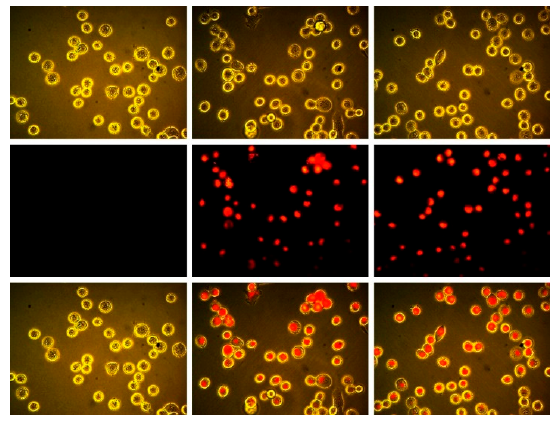
Figure 4. Brightfield ( upper ), epifluorescence (( middle ) λ ex = BP 528–553 nm, λ em = BP 578–633 nm), and ( lower ) overlay images of MDA-MB 231 breast tumor cells. DMSO control ( left ), treated with 50 µM F 3 SPc(C 3 ) ( center ), and 50 µM F 3 SPc(C 1 ) ( right ) for 15 min (400×).